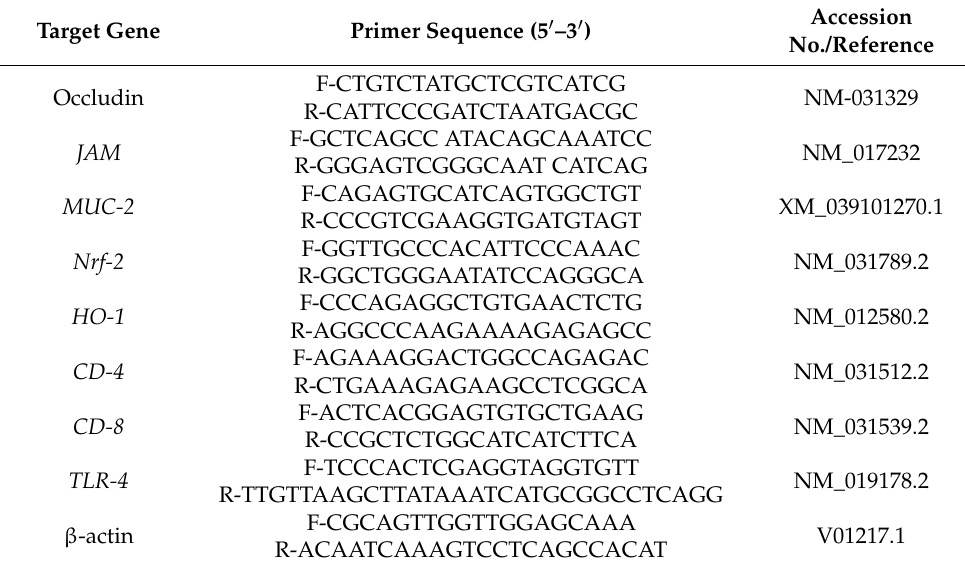
Table 2. Primer sequences utilized for qRT-PCR analysis of targeted gene